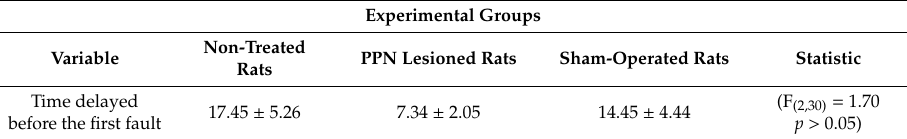
Table 2. Comparison of the time delayed for the rats before the first fault during the execution of grid test 30 days after pedunculopontine nucleus lesion ((F (2,30) = 1.70 p > 0.05)). One-way ANOVA test. The data represent x ± E.E.M.